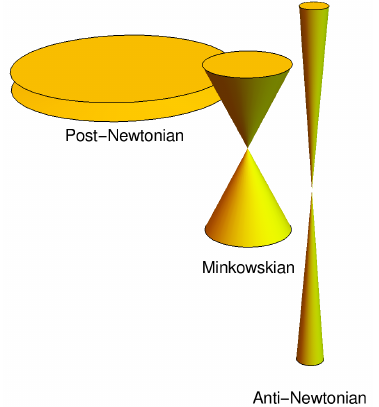
Figure 1. Post-Newtonian versus anti-Newtonian lightcone